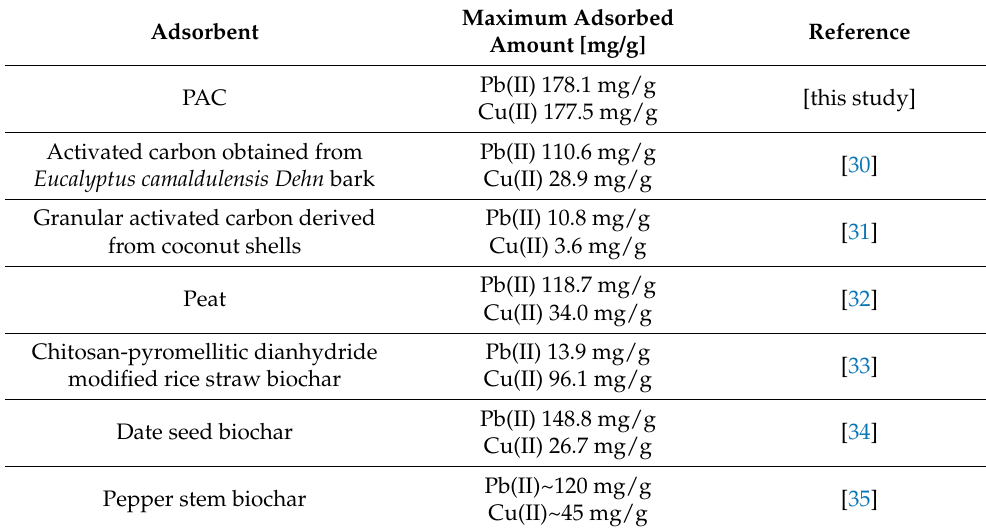
Table 9. Adsorption capacity toward Pb(II) and Cu(II) ions for various carbonaceous